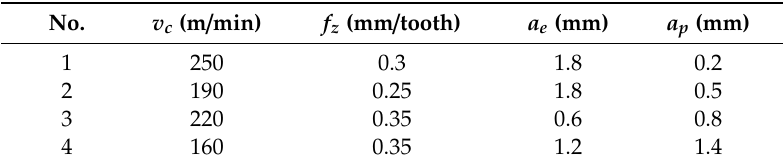
Table 1. Cutting conditions of the